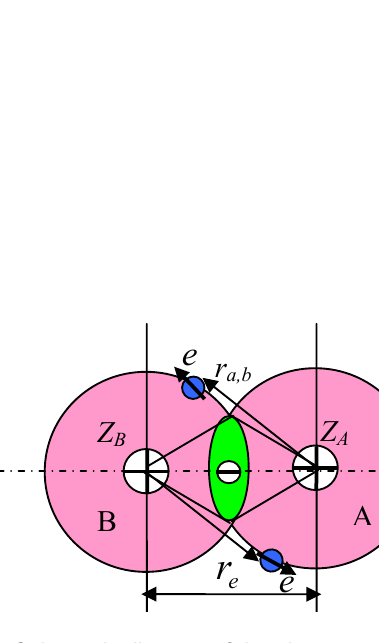
Figure 1 – Schematic diagram of the electron exchange between two identical atoms Рис . 1 – Схема обмена электронами между двумя одинаковыми атомами Слика 1 – Шематски приказ размене електрона између два